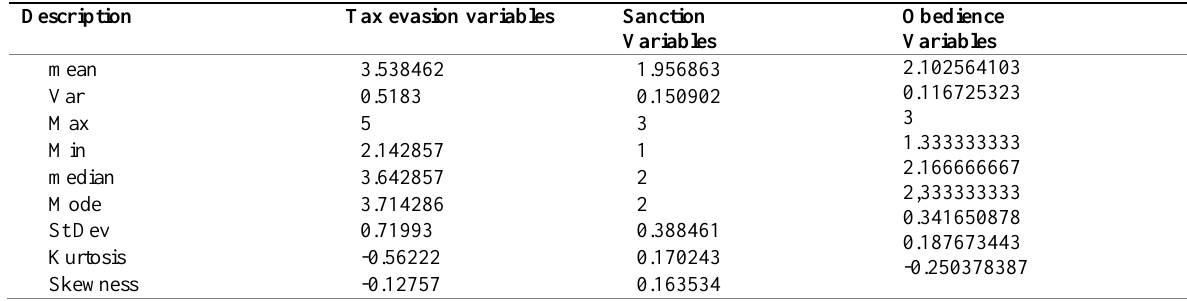
Table 2: Results Test Statistics Descriptive